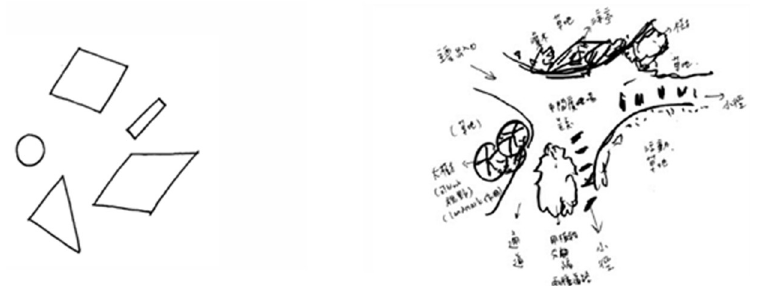
Fig 3. Examples of geometric cues as experimental